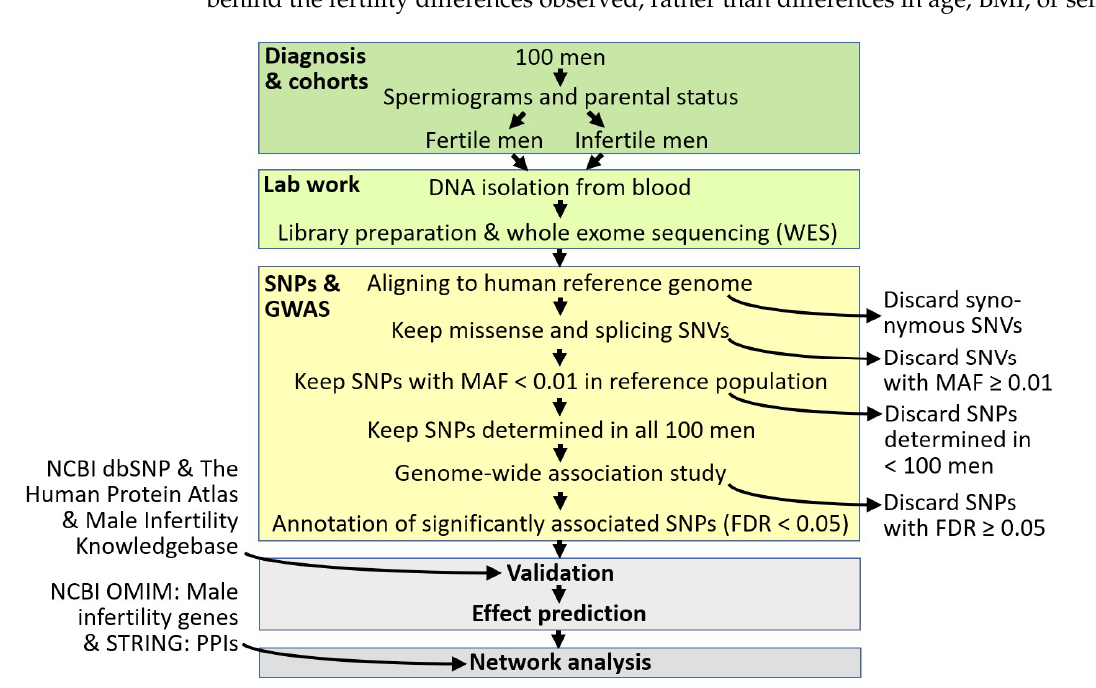
Figure 1. Workflow of the present study. Filtering steps leading to the discard of data are given on the right, and downstream inclusion of data from databases (NCBI dbSNP, The Human Protein Atlas, Male Infertility Knowledgebase, NCBI OMIM, STRING) on the left. Bold type relates to Section 4. For more details, see there. Abbreviations: FDR—false discovery rate; MAF—minor allele frequency; NCBI OMIM—Online Mendelian Inheritance in Man database at NCBI; NCBI dbSNP—SNP database at NCBI; PPI—protein–protein interaction; SNP—single-nucleotide polymorphism; SNV—single-nucleotide variant; GWAS—genome-wide association study. Table 1. Cohort characteristics inclusive of spermiogram parameters. Parameter Infertile Cohort *